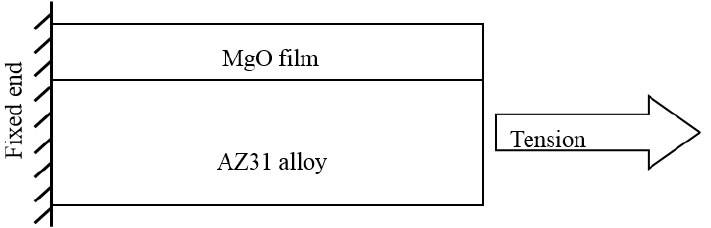
Figure 3. Model geometry of AZ31 alloy and corrosive film considered in study. Table 1. Properties of alloy and film used in FEM simulation [18,19]. FEM: Finite Element Modelling. Parameter